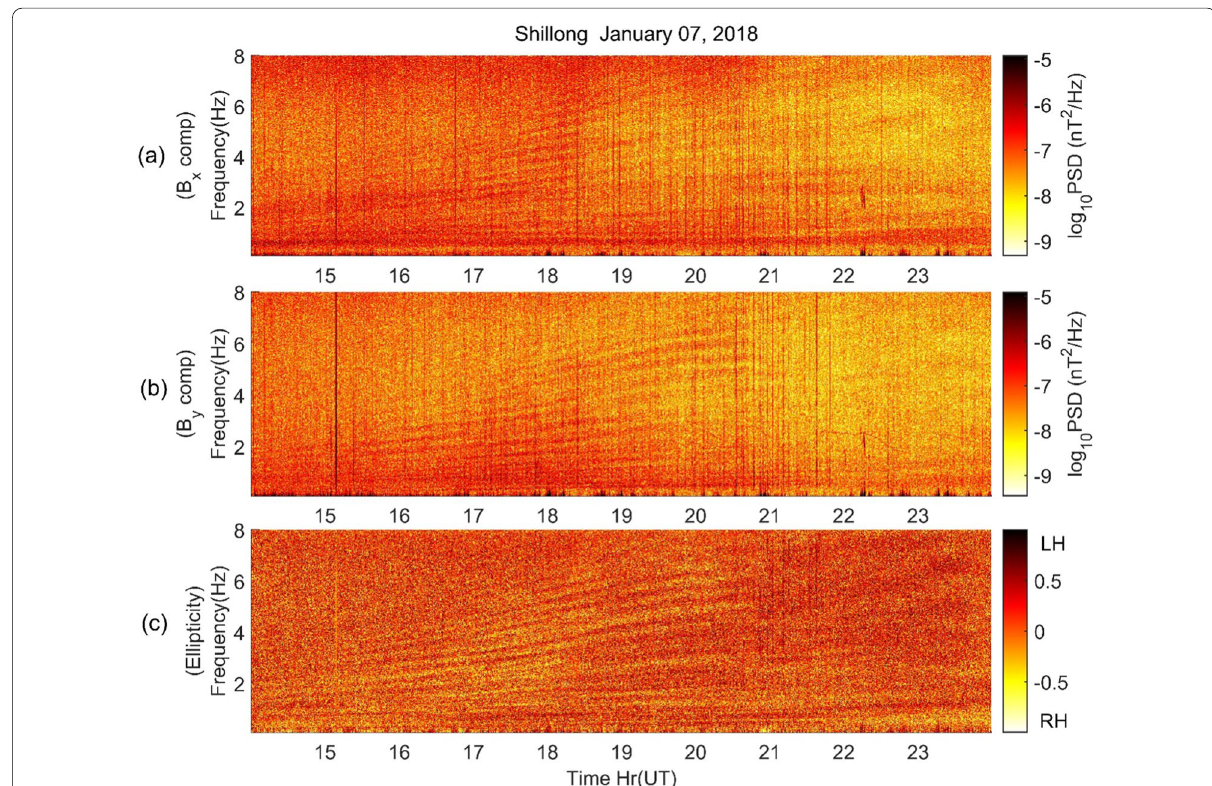
Fig. 1 Dynamic spectra of B x ( a ), B y ( b ) components and ellipticity (ǫ) ( c ) as an example of IAR observed at Shillong